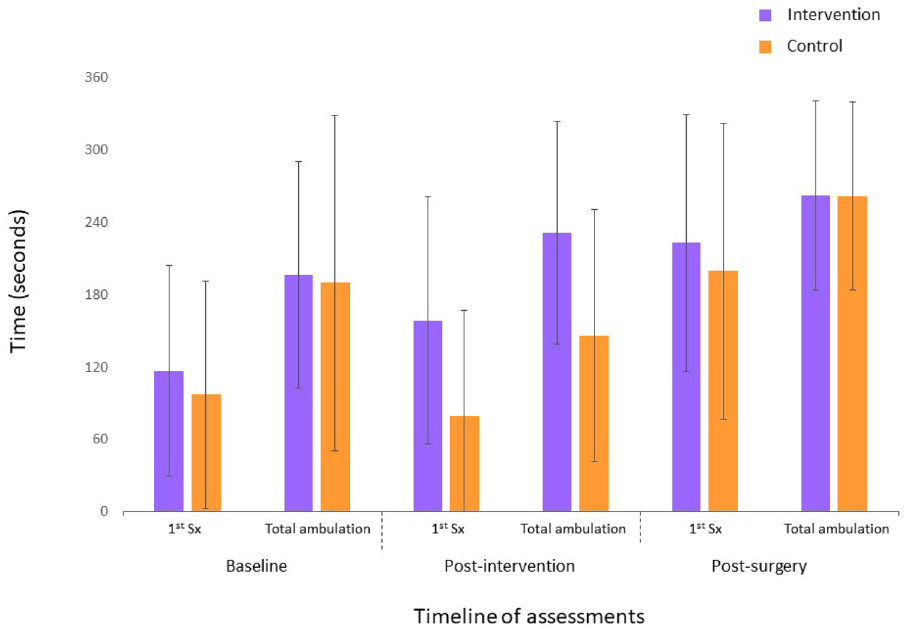
Figure 4. Comparison of walking capacities (means ± SD) (Greater scores indicate better walking capacities; 1st Sx walking time to first